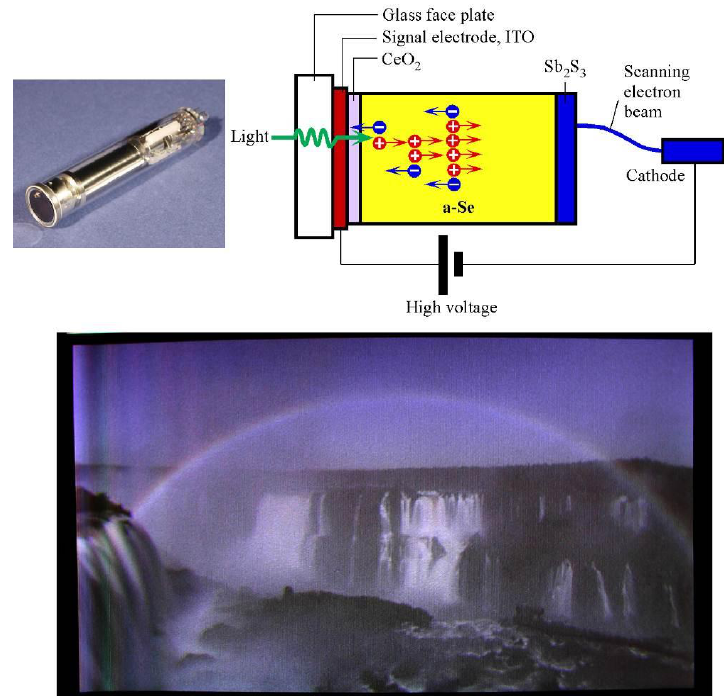
Figure 14. Top left. A HARP tube is a TV pick-up (video) tube with avalanche gain; it is called a Harpicon. Top right. A schematic illustration of the HARP and its operation under avalanche. Bottom. A snap-shot image from a real time movie of a rainbow formed under moonlight at night at Iguazu Falls, Brazil, taken by a HDTV-Harpicon. (Courtesy of Dr. Kenkichi Tanioka, NHK,